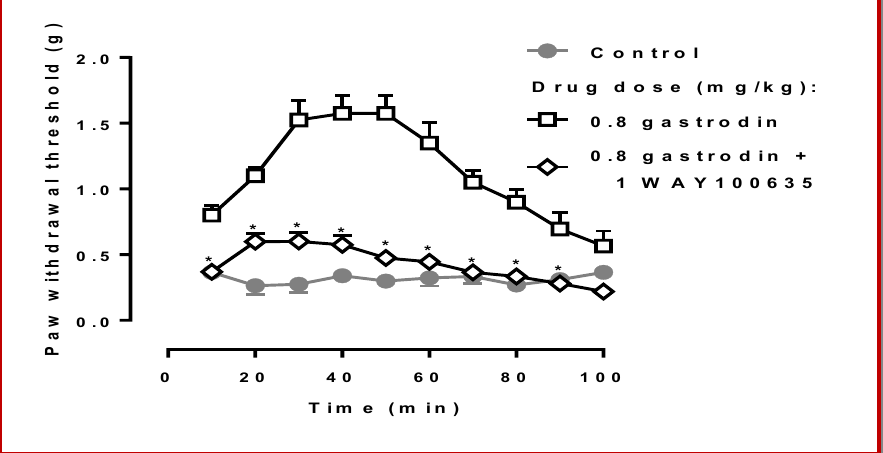
Figure 3: Effect of WAY100635 on 0.8 mg/kg gastrodin-induced anti-hyperalgesia in mice (n = 8 per group). *p<0.05 as compared to corresponding 0.5 mg/kg gastrodin